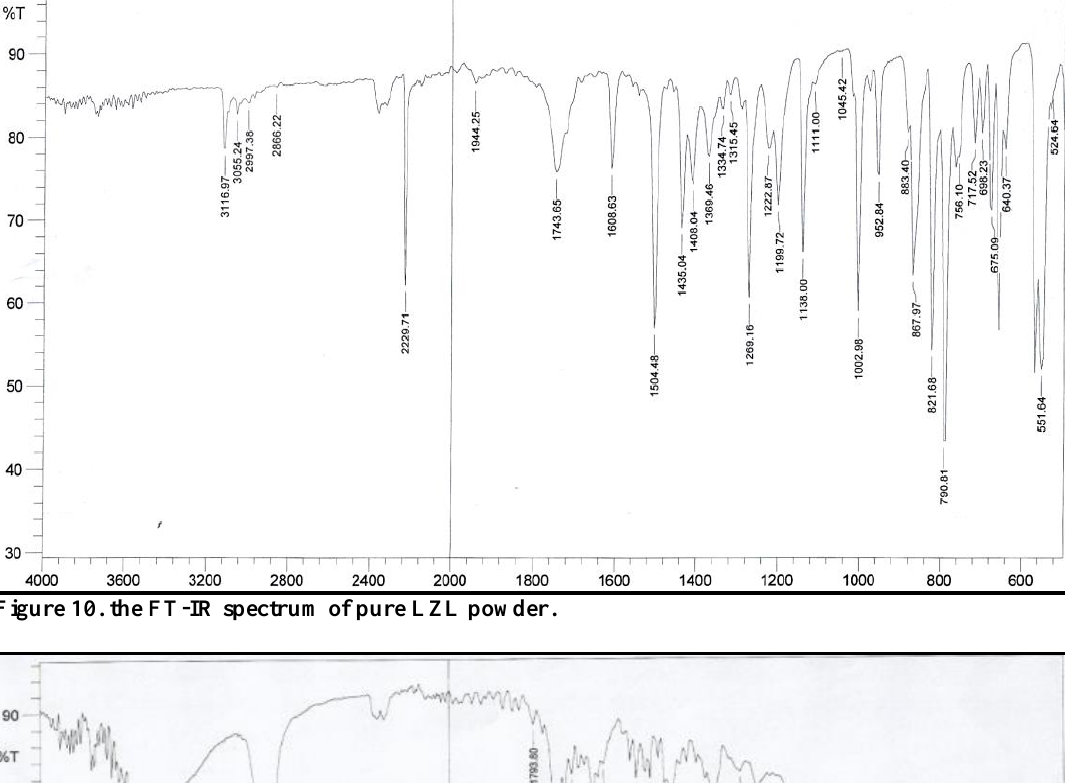
Figure 10. the FT-IR spectrum of pure LZL powder.